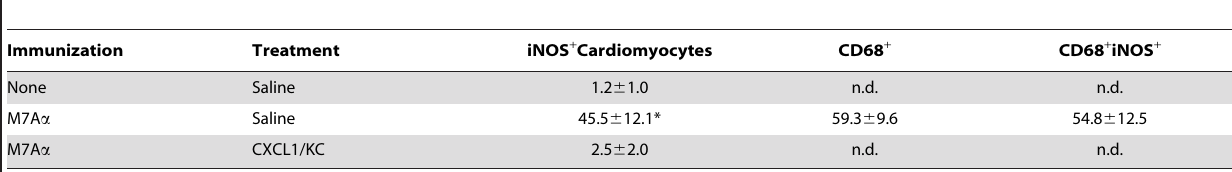
Table 1. CXCL1/KC prevents the induction of iNOS protein expression in hearts of mice challenged with cardiac-specific a -myosin- heavy chain-derived peptide M7A a